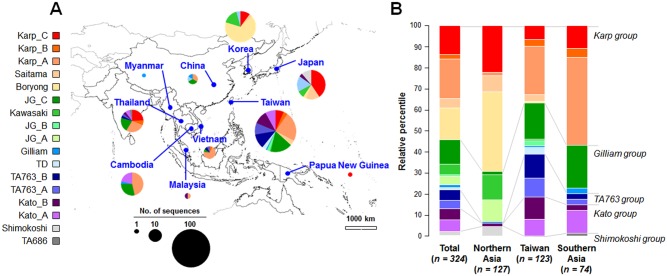
Geographical distribution of O. tsutsugamushi genotypes in endemic countries.A. The relative proportion of each genotype reported in the indicated endemic country is presented and the pie size is proportional to the number of sequences reported. The number of tsa56 sequences used for each country is as follows: Taiwan (123), Korea (69), Japan (52), Thailand (29), Cambodia (28), China (9), Malaysia (2), Myanmar (1), and Papua New Guinea (1). B. Relative proportion of each genotype reported from Taiwan, northern endemic area (Korea, Japan, and China), and southern countries (Thailand, Cambodia, Vietnam, Malaysia, Myanmar, and Papua New Guinea) is presented. The number of sequences from each group is indicated below the bar graphs.